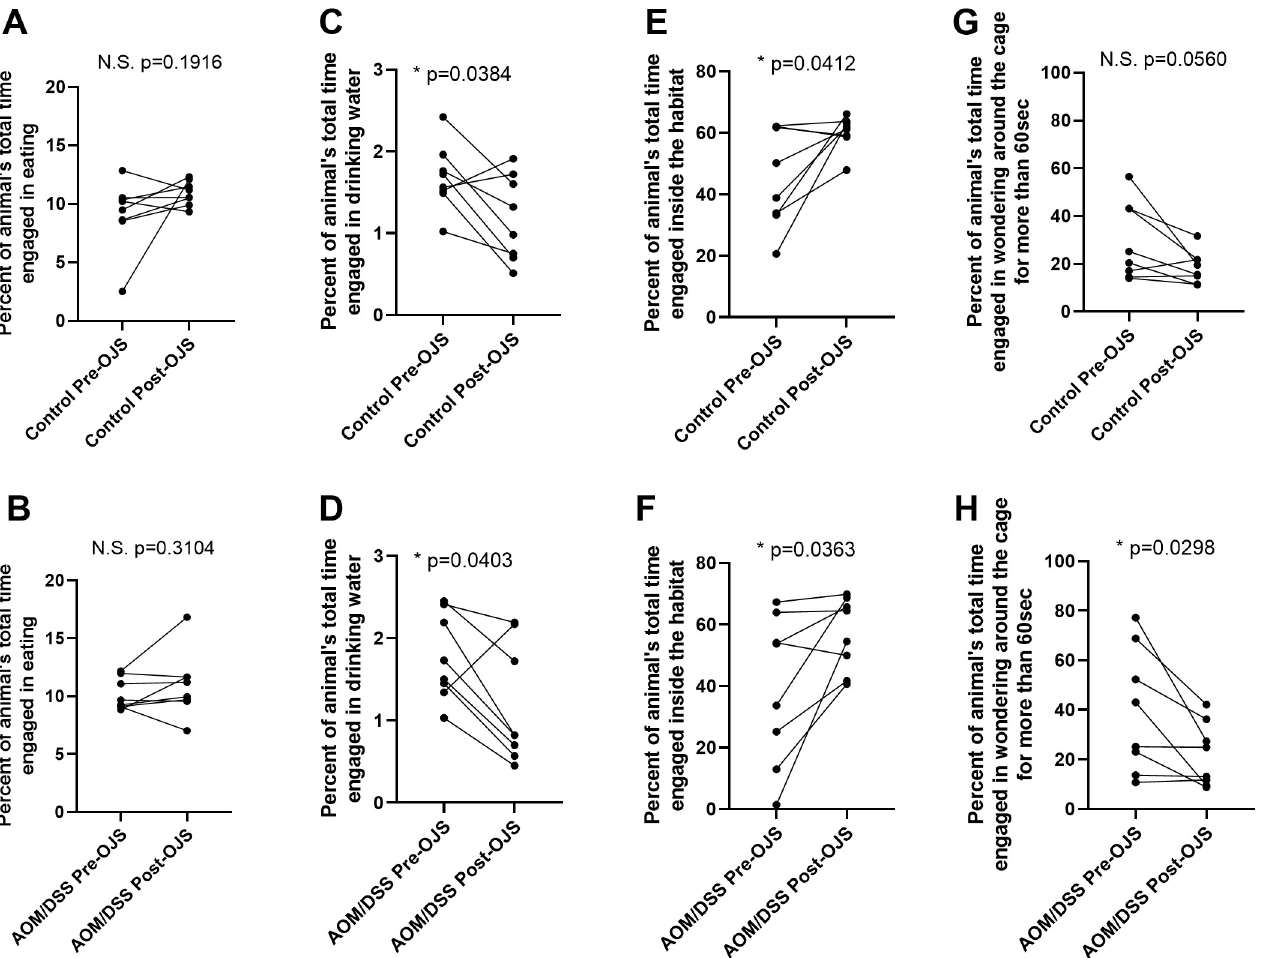
Fig 7. Behavioral time budget pre- and post-OJS administration in the drinking water. Percentage time Control non-cancer mice and AOM/DSS mice spent eating (A, B), drinking water (C, D), inside the habitat (E, F) and long roaming (G, H). � Indicates statistical significance between groups (p < 0.05) from paired t-test, n =